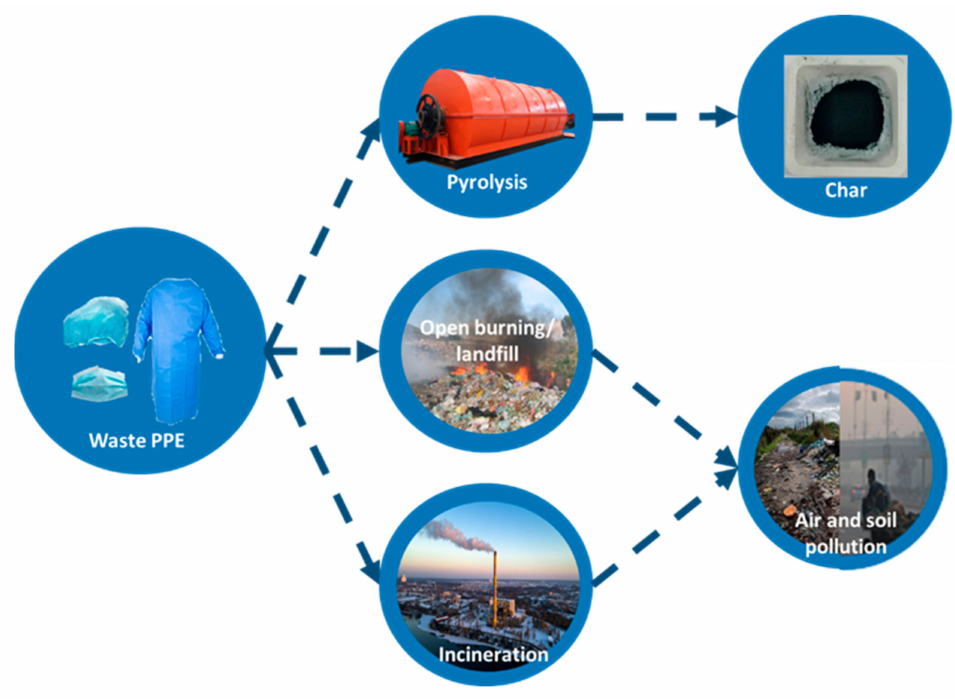
Figure 1. Pyrolysis of waste plastic to char